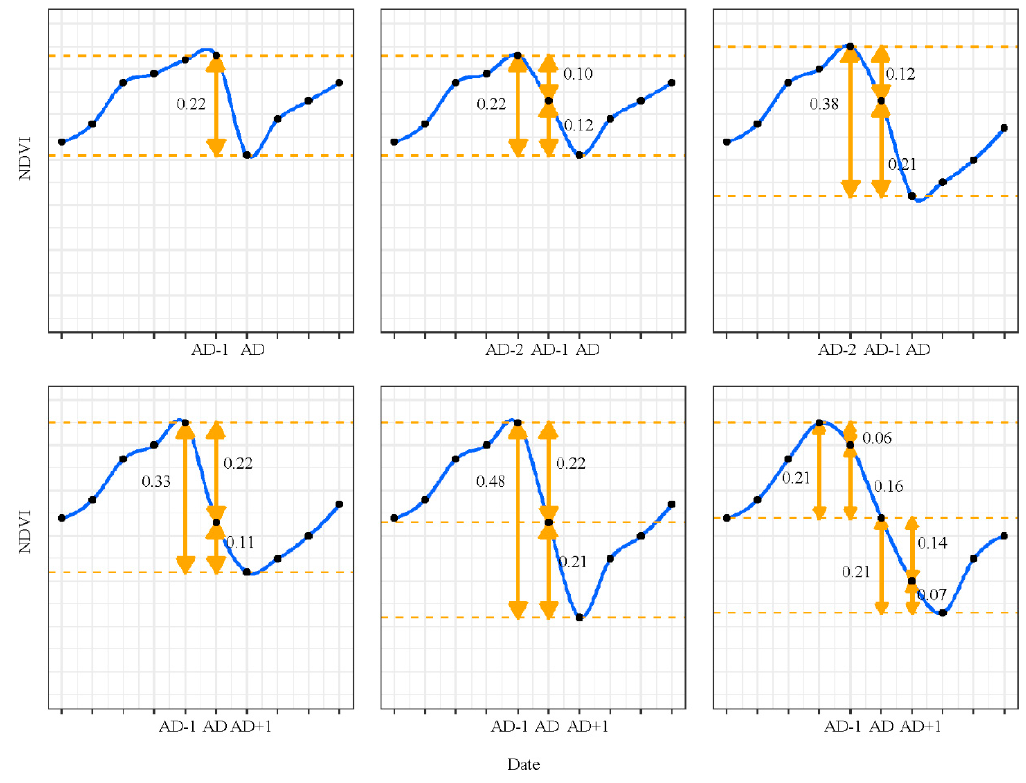
Figure 5. Graph showing illustrative profiles and mowings. The black dots represent available imagery. Mowing date is indicated as AD, however the exact event date is between AD-1 and AD. If mowings were detected in subsequent dates, only the first was considered.